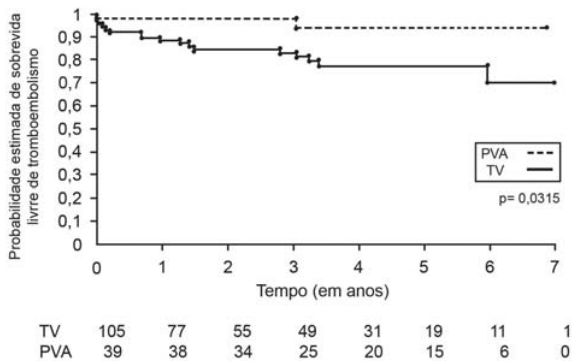
Fig. 3 - Curvas de sobrevida livre de complicações tromboembólicas